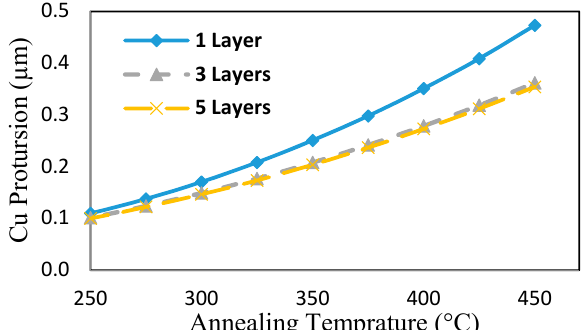
Figure 8. Cu protrusions of multilayer TSVs via annealing temperature.